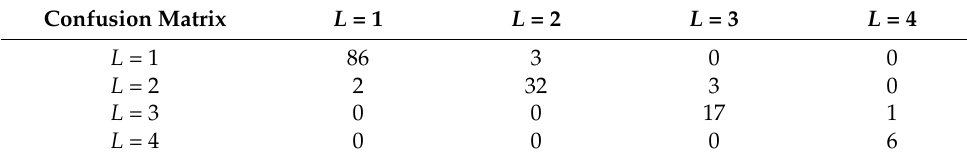
Table 2. The confusion matrix of the test set.